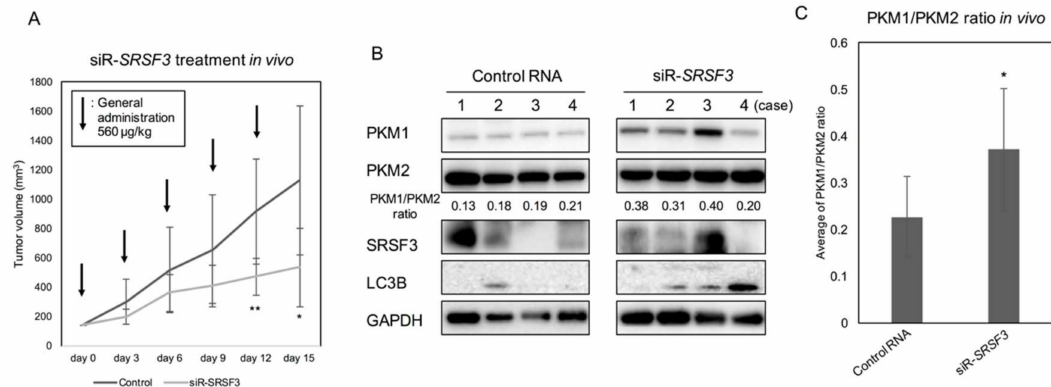
Figure 5. Effect on tumor of silencing of SRSF3 in colorectal cancer cell line DLD-1 xenograft model mice in vivo. ( A ) Time-course of tumor growth in mice intravenously injected with control RNA or siR-SRSF3 (560 µ g/kg) carried by nanopolymer. Arrow, general injection; ( B ) Western blot of PKM isoforms, SRSF3, and LC3B in xenograft tumor samples from control RNA- or siR- SRSF3 treated mice. Numbers represent the ratios of PKM1/PKM2 calculated by densitometric values of PKM1 and PKM2. The representative 4 cases were shown; ( C ) Average values of PKM1/PKM2 ratio in control and siR- SRSF3 treated groups were indicated (B) ( n = 8). * p < 0.05; ** p < 0.01 (Student’s t